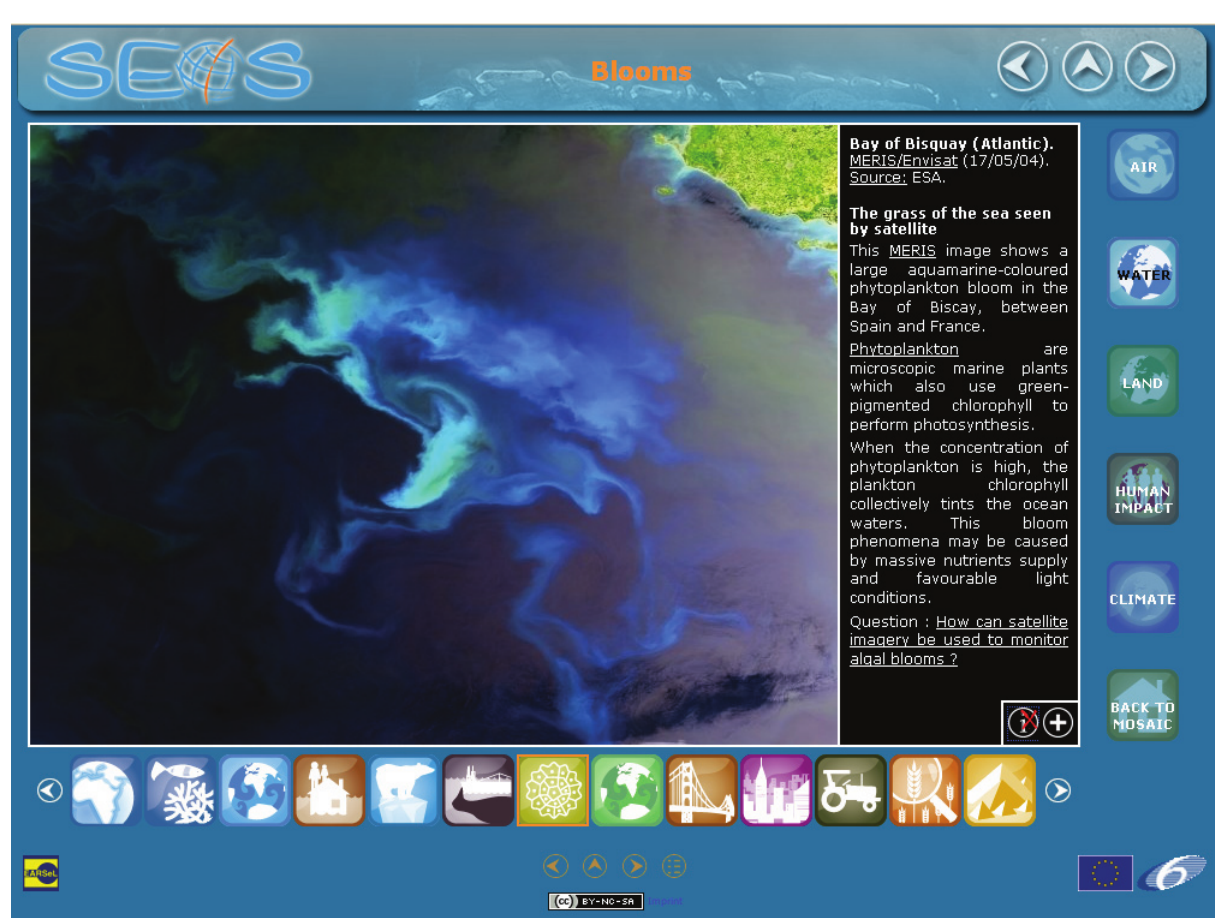
Figure 3: A webpage on marine phytoplankton blooms in the tutorial A World of Images, showing a bloom in the Bay of Bisquay. Explanations in the black window (activated with a click at the ‘i’ symbol) include links to other more detailed SEOS pages. The full resolution image can be accessed with a click on ‘+’. Navigational arrows allow to flip pages. Logos lead to other topics of Earth observation..